Question: Condense the content of this figure into a single sentence.
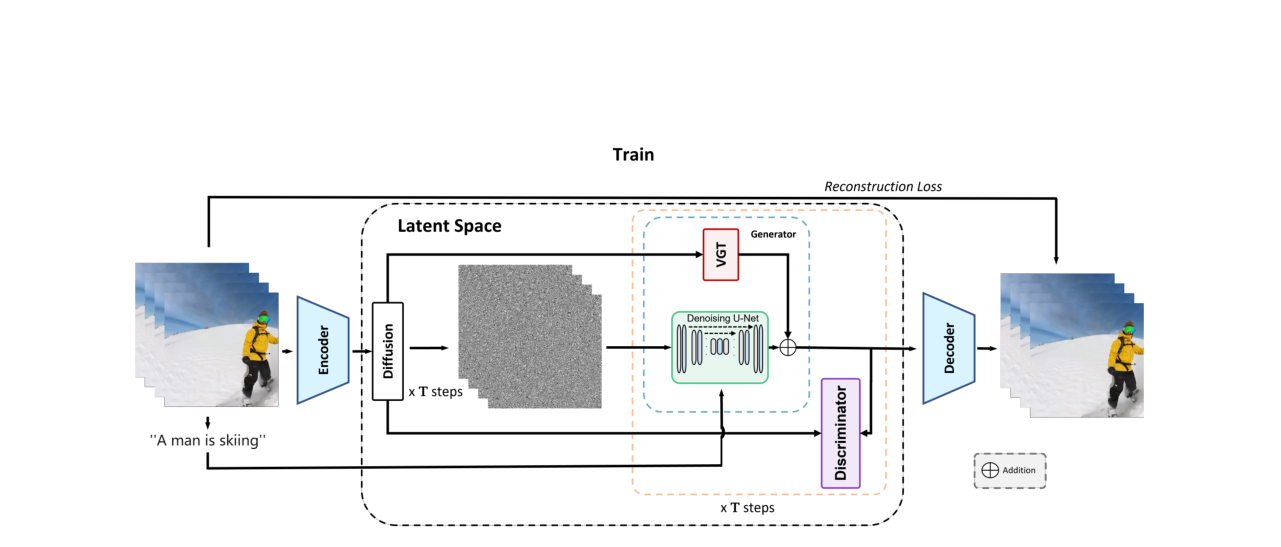
Answer: The process of training the networks. VGT extracts intrinsic information from latent variables, considering various time steps for noise incorporation, and especially including the clean latent variable devoid of noise, namely the original latent variable z. As VGT is not trained ever, the output of VGT is tiny thus the change of the output is small, which is helpful to improve the consistency of different frames without changing the content a lot. The discriminator receives the predicted noise and the noise residuals for corresponding time steps in the diffusion stage.